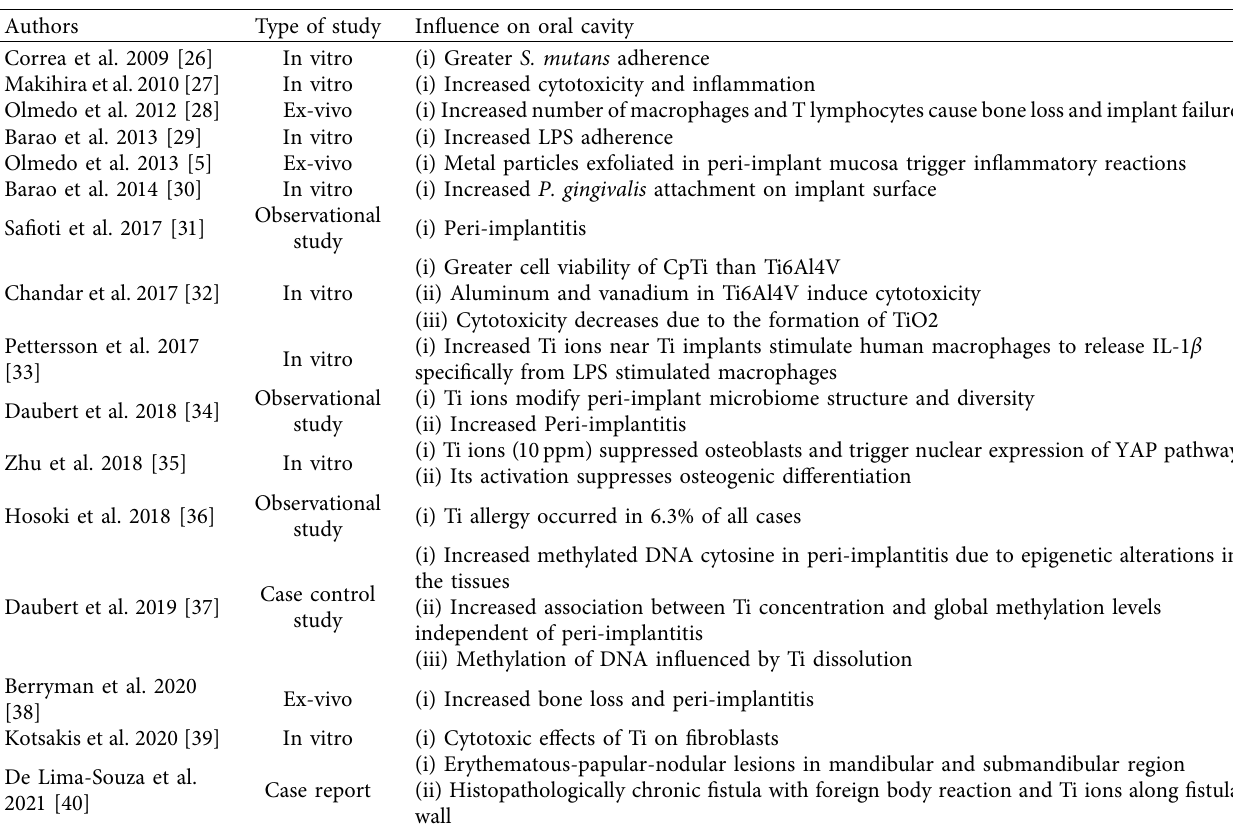
Table 2: Various toxic effects of titanium